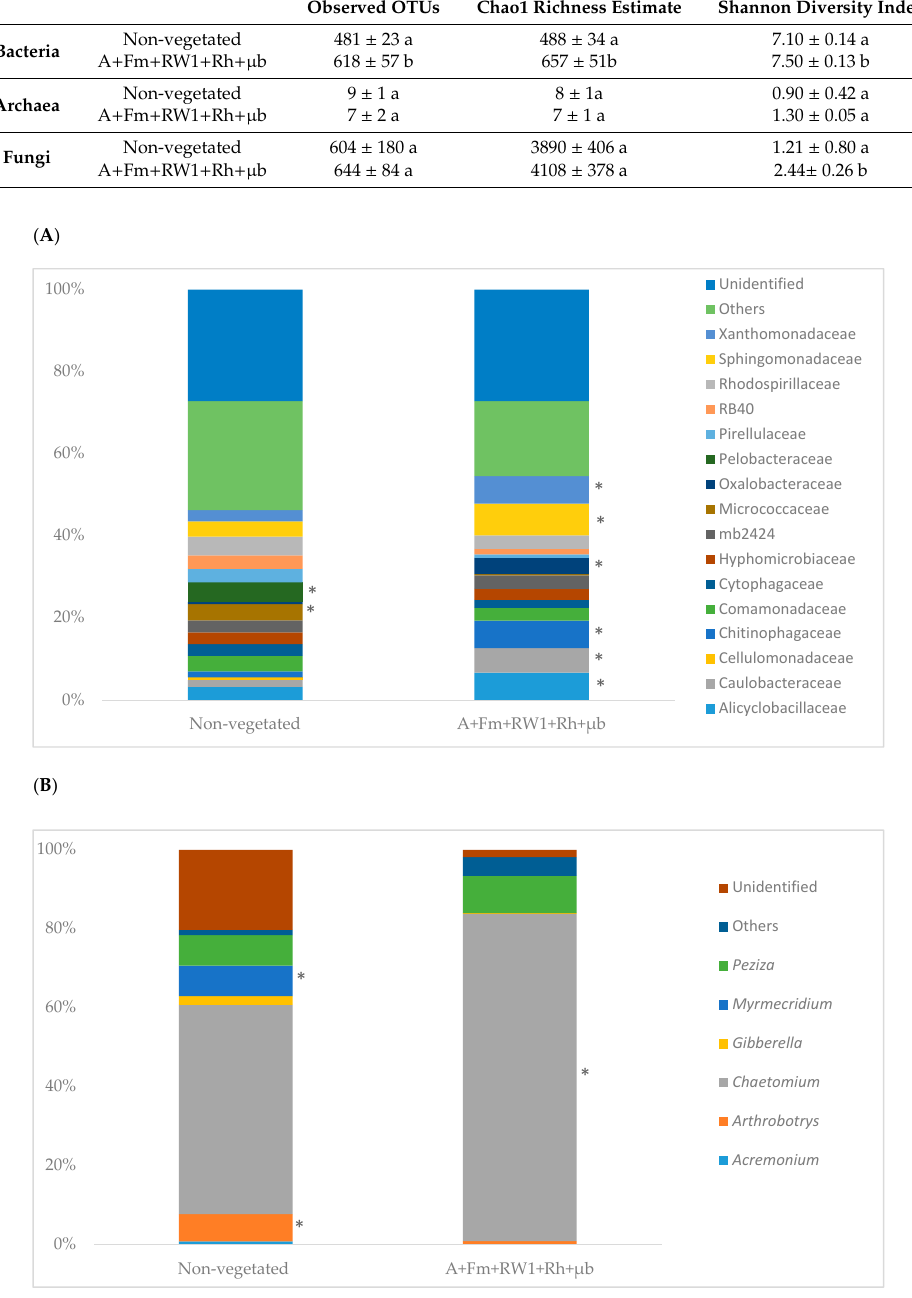
Figure 3. Relative abundances of major ( A ) bacterial Family of 16S rRNA gene dataset and ( B ) genera of fungal ITS dataset. (*) indicate significant differences between different bacterial family and fungal genus on non-vegetated soil and A+Fm+RW1+Rh+µb condition according to the Tukey (HSD) test ( p ≤ 0.05).